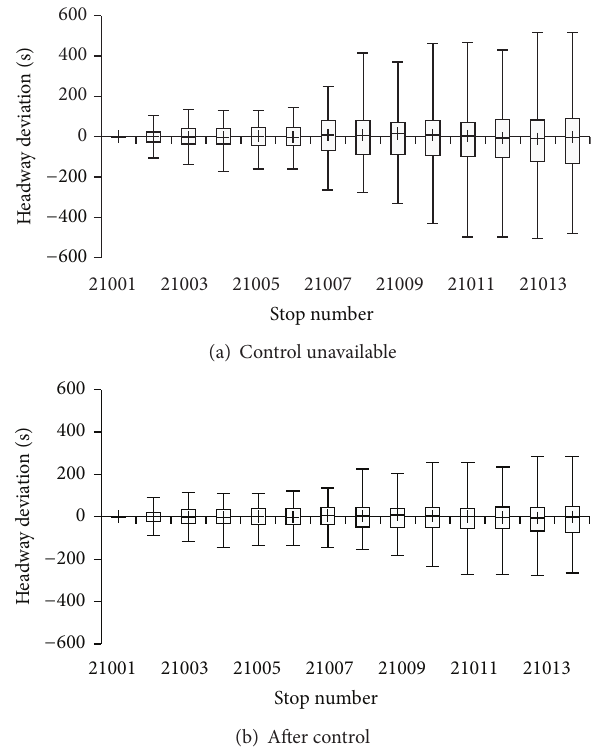
Figure 7: Distribution of headway deviation with buses traveling on the route.